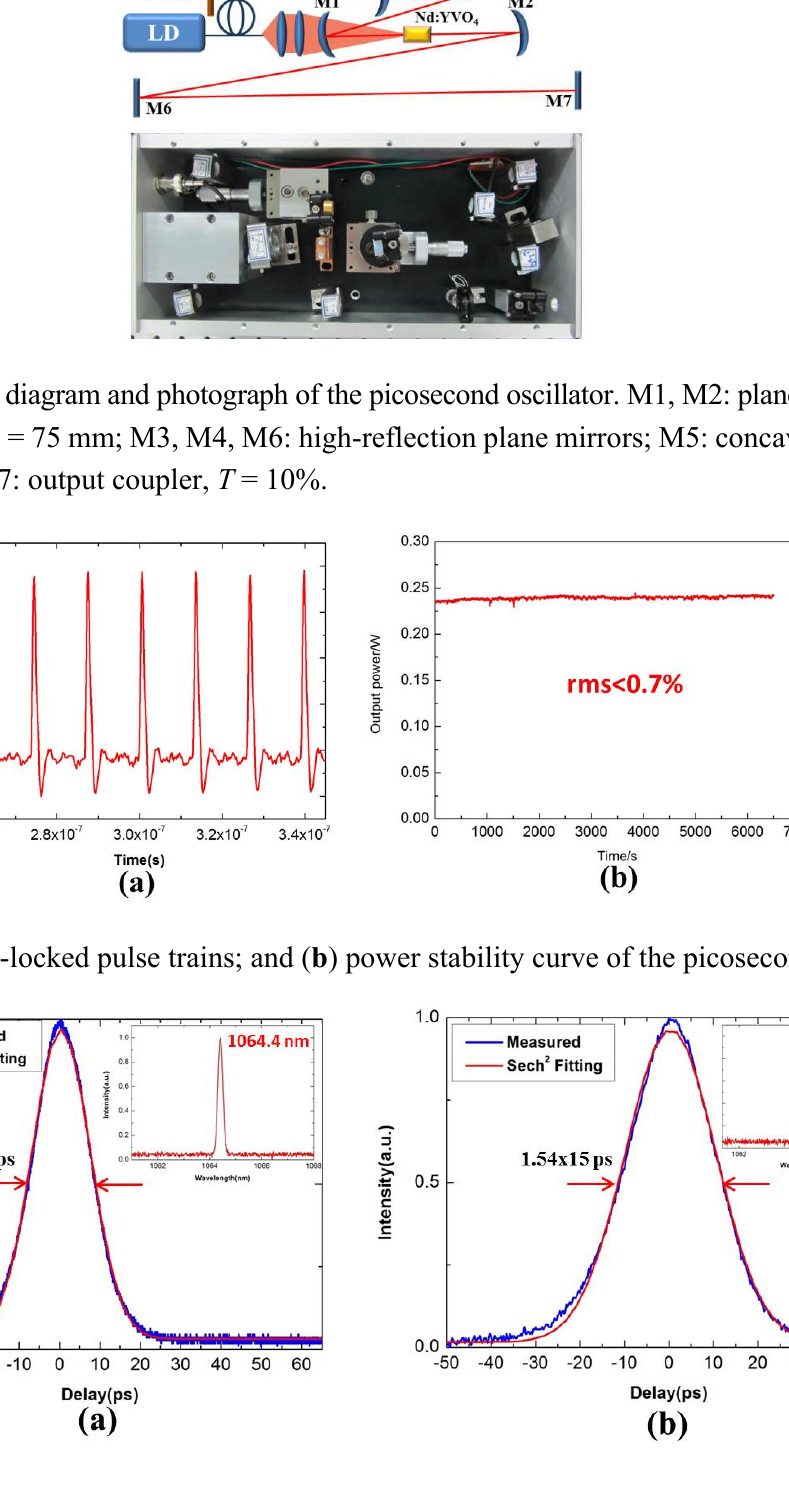
Figure 3. Intensity autocorrelation traces and spectra (insets) of the mode-locked pulses; ( a ) with dispersion compensation, pulse duration was 10 ps; ( b ) without dispersion compensation, pulse duration was 15 ps if sech 2 -pulse shapes were